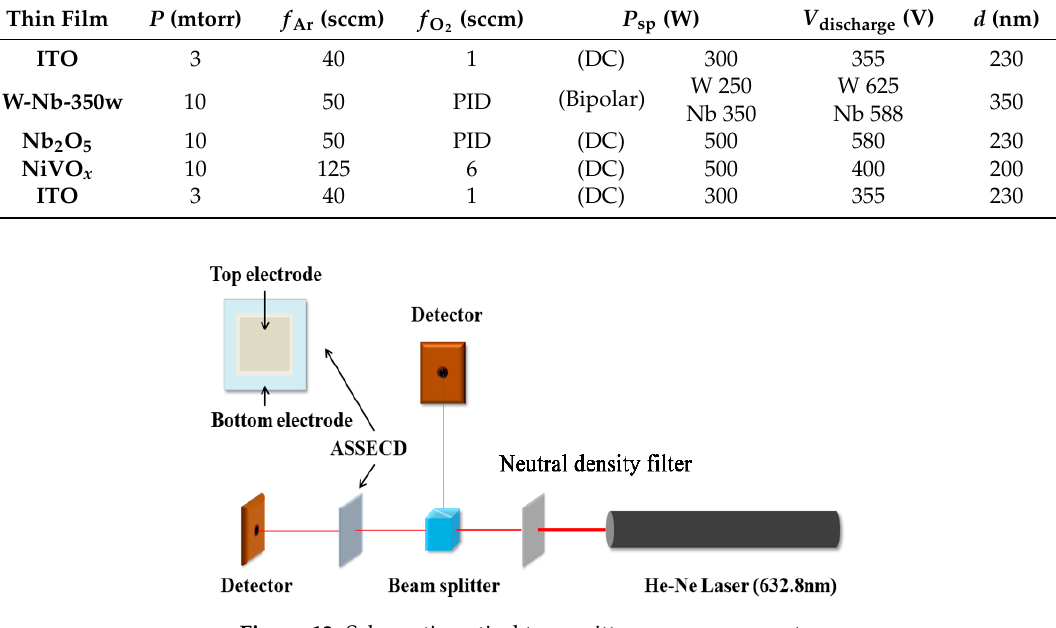
Figure 13. Schematic optical transmittance measurement.